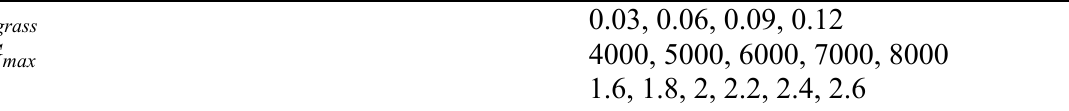
Table A2.1 – Parameter values for factorial design. 4 points along k along f , for a total of 120 condition sets, and 5 repetitions for a total of 600 model runs in the